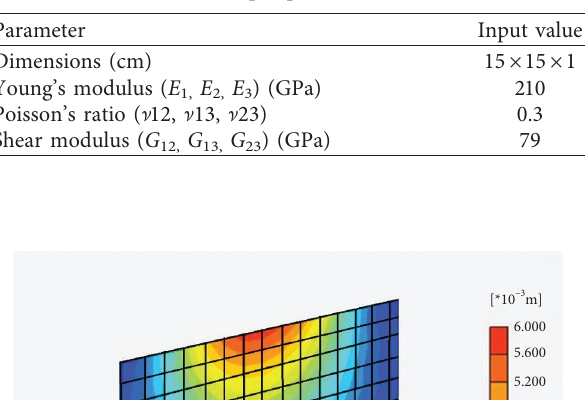
Table 9: Plaxis 3D input parameters of foundation.